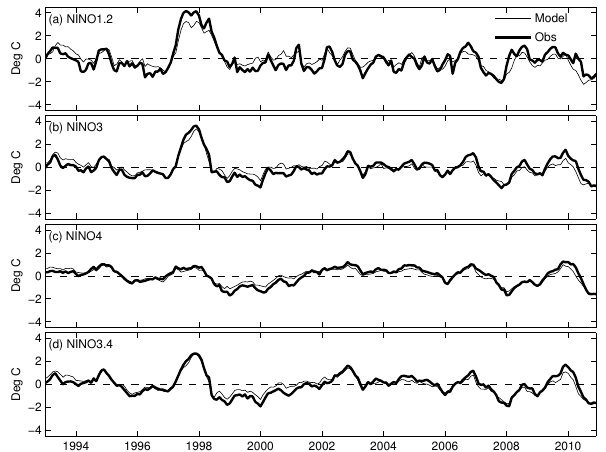
Fig. 6. Time series of the (a) NINO1.2, (b) NINO3, (c) NINO4, and (d) NINO3.4 SST anomalies from observations (OSTIAv2) and the model (OFAM3).